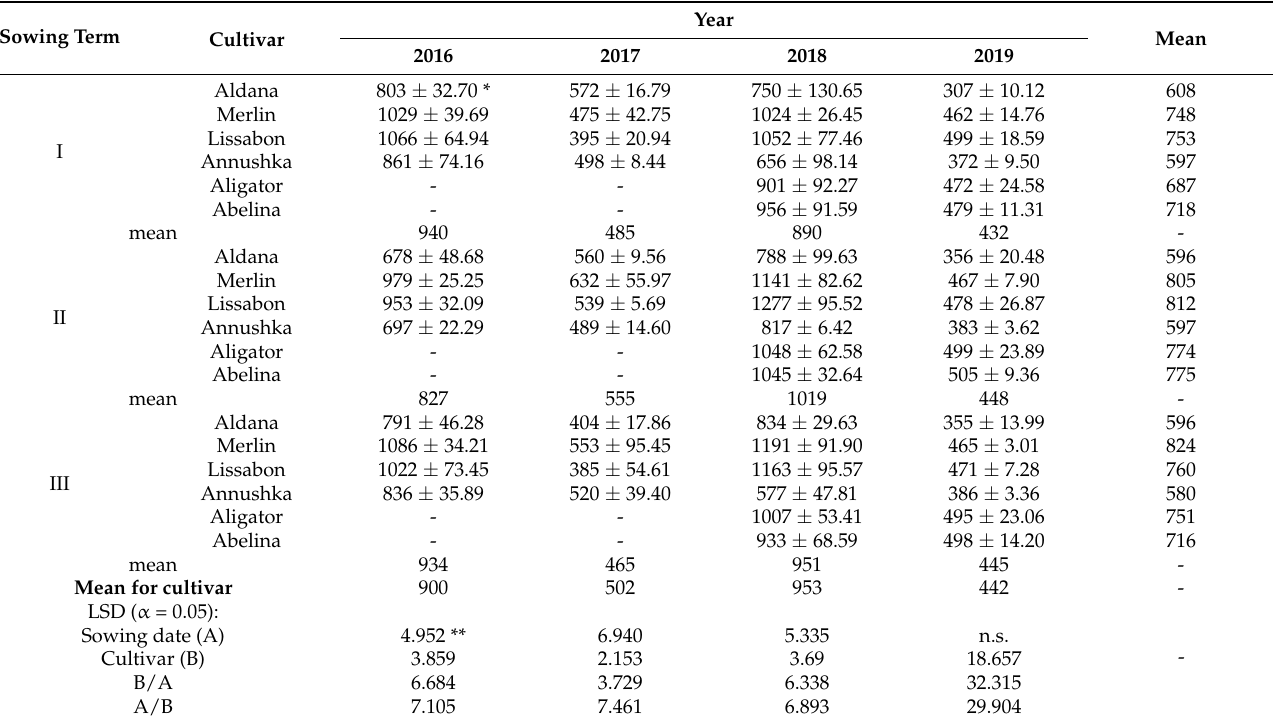
Table 4. Protein yields of soybean cultivars depending on sowing date (kg ha − 1